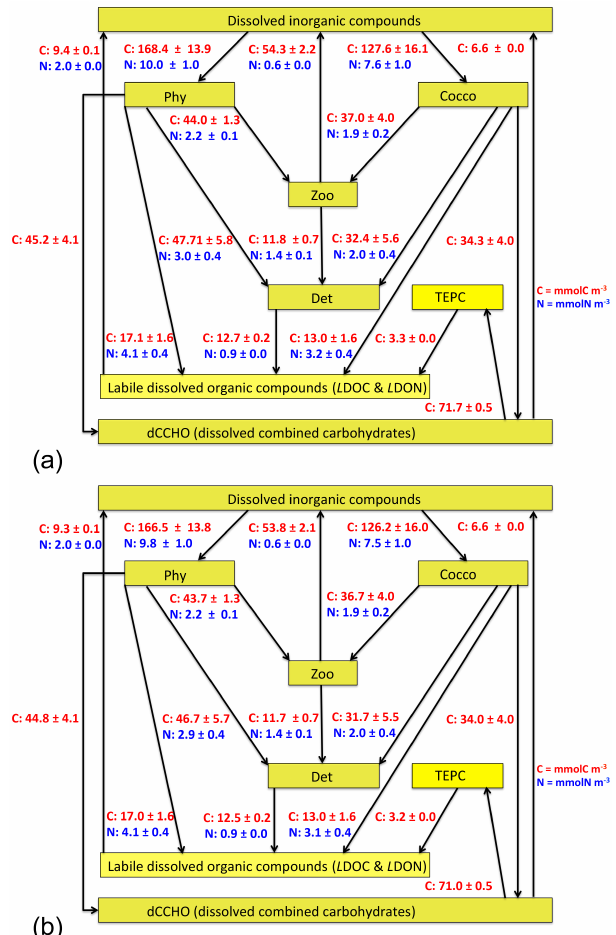
Figure 10. Carbon and nitrogen fluxes estimated by the model in mesocosms with high observed calcification but different CO 2 treat- ment, high (a) and low (b) . All the arrows that point downwards show flux estimates from the respective compartment on the right hand side, whereas arrows pointing upwards show values on the left hand side.